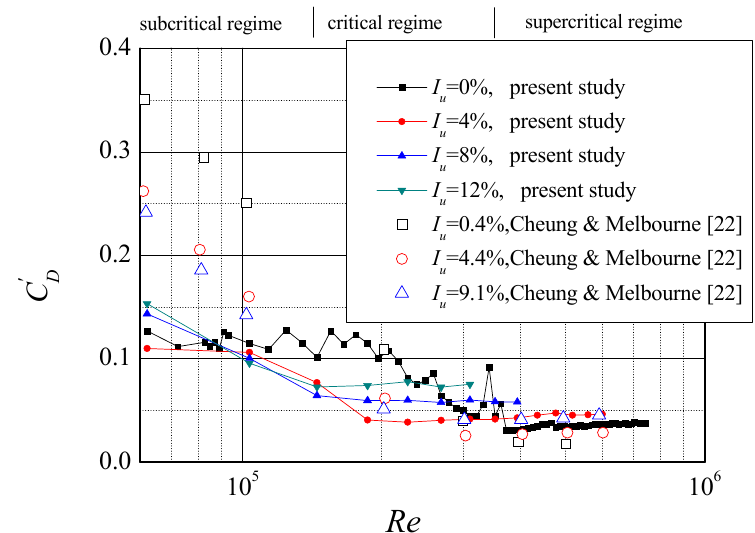
Figure 17 . Standard deviation of drag coefficient of circular cylinder in turbulent flow. Figure 17. Standard deviation of drag coe ffi cient of circular cylinder in turbulent flow.